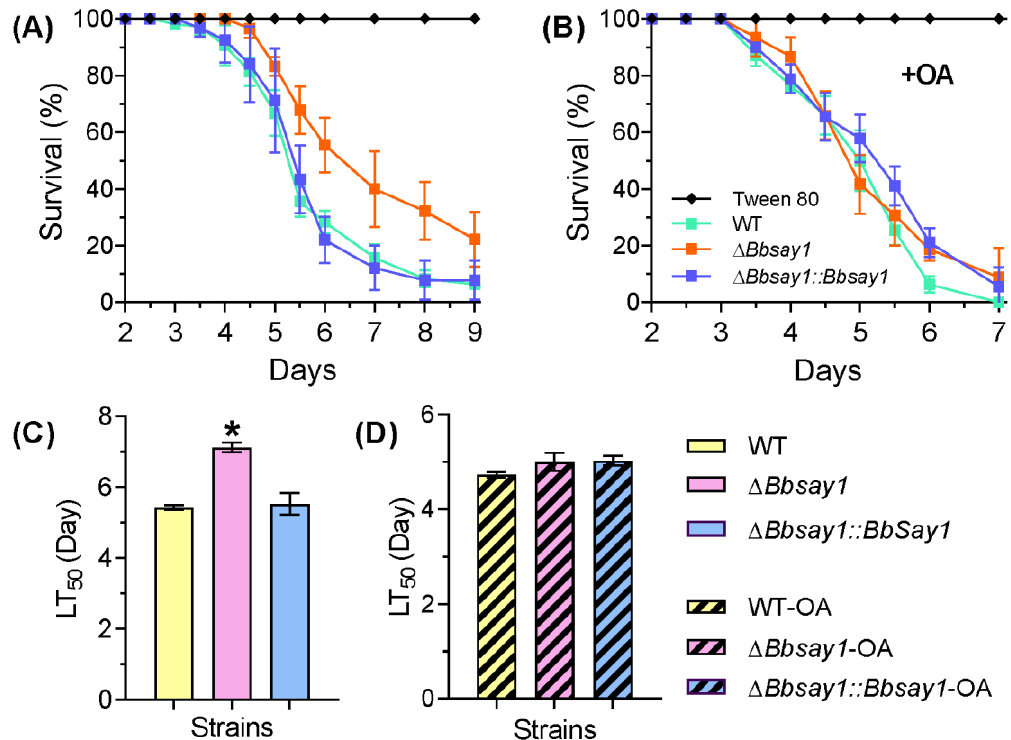
Figure 3. Fungal virulence. Conidial virulence was assayed for the wild-type (WT), ∆ Bbsay1, and ∆ Bbsay1::Bbsay1 strains. The conidial suspension was flooded onto the host cuticle, and then, the inoculated insects were cultured at 25 ◦ C. The survival trend was recorded daily ( A ), and the accumulative mortality was used to calculate the median lethal time (LT 50 ) with a Probit analysis ( C ). In the feeding test, oleic acid (OA) was included in the conidial suspension, and accumulative mortality was used to calculate the survival trend ( B ) and LT 50 ( D ). A Tween-80 solution was used as blank control. The asterisk on the column indicates the significant difference in the LT 50 value between the ∆ Bbsay1 and the wild-type or complemented strains (Tukey’s HSD: p < 0.05). Error bars: standard